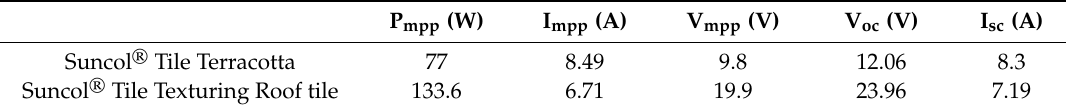
Table 3. Electrical parameters at standard test conditions of the tested module at maximum power point (P mpp ); current at maximum power point (I mpp ); voltage at maximum power point (V mpp ); open circuit voltage (V oc ); and short-circuit current (I sc ).